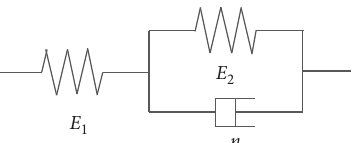
Figure 1: Physical model of the standard linear solid constitutive relation of viscoelasticity.